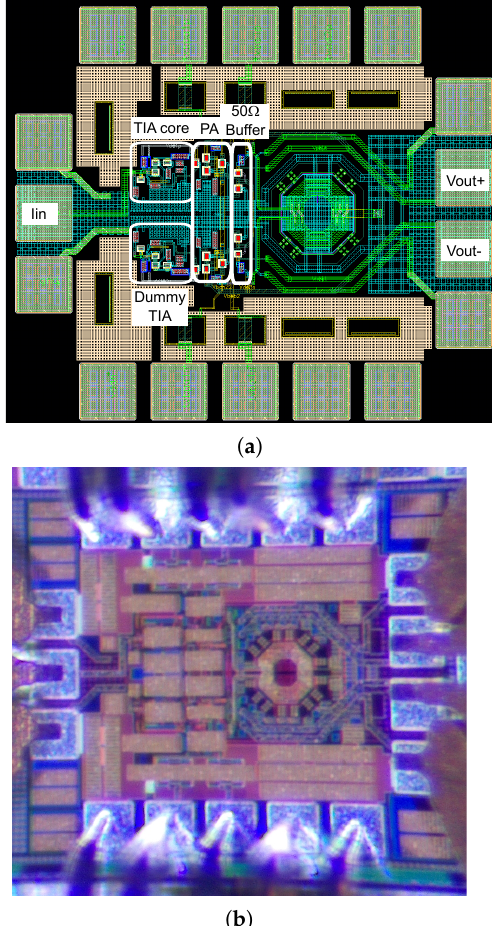
Figure 8. Full schematic of the proposed TIA, including post amplifier (PA) and 50 Ω buffer.